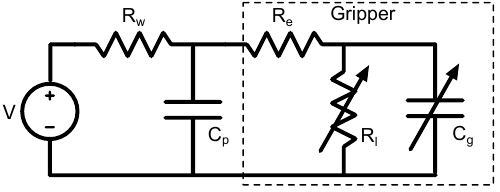
Figure 1. Equivalent circuit of the